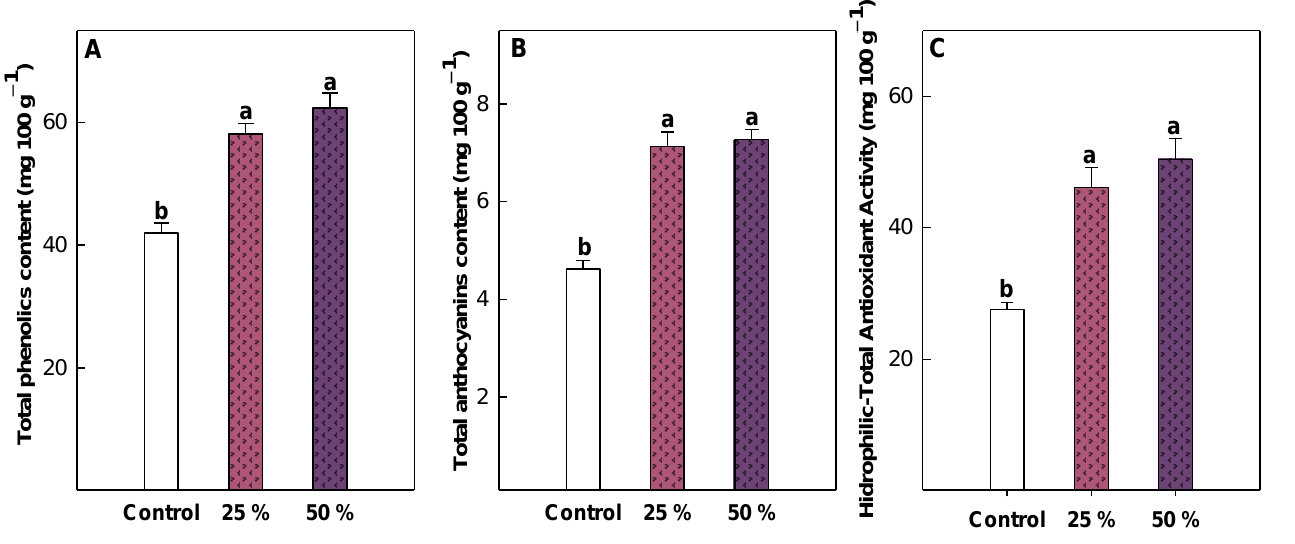
Figure 2. Effects of berry thinning methods on total phenolics ( A ) and total anthocyanins ( B ) content, as well as hydrophilic total antioxidant activity ( C ) of the whole berry (flesh and skin tissues) at harvest in the 2019 growing season. Data are the mean ± SE of three biological replicates. Different letters show significant differences among methods for each parameter at p ≤ 0.05 according to the Tukey’s multiple range test.